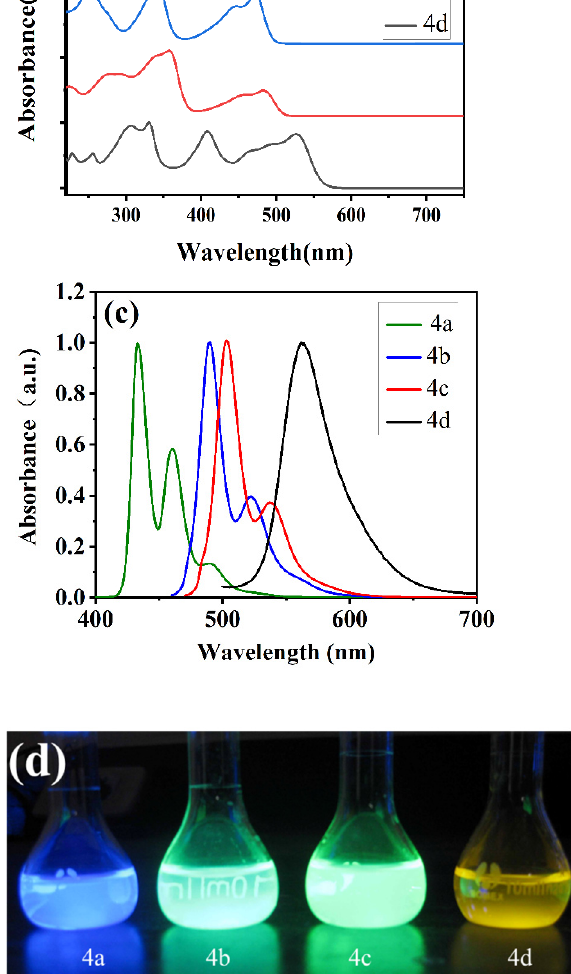
Figure 1. ( a ) UV/Vis spectra of 4a – 4c in CH 2 Cl 2 : [4a–4d] = 1.0 × 10 − 4 M; ( b ) normalized UV/Vis